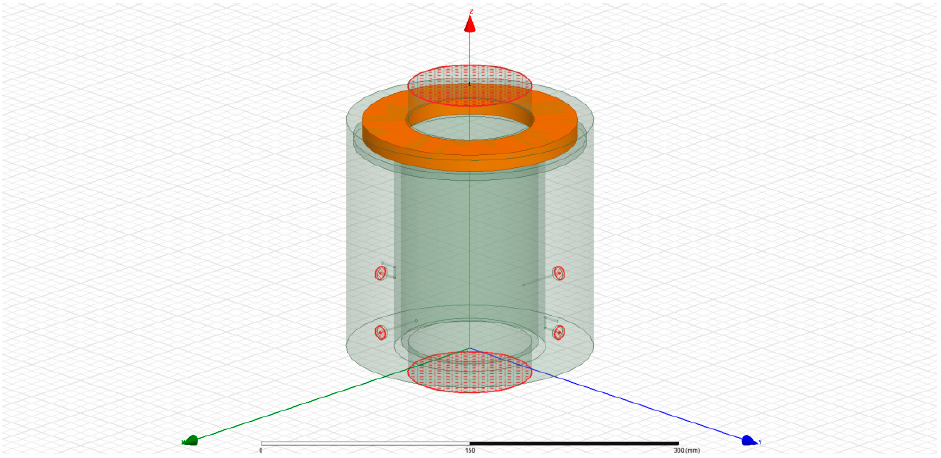
Figure A2. Waveport excitations assigned across beam entry, exit and all pickup ports.